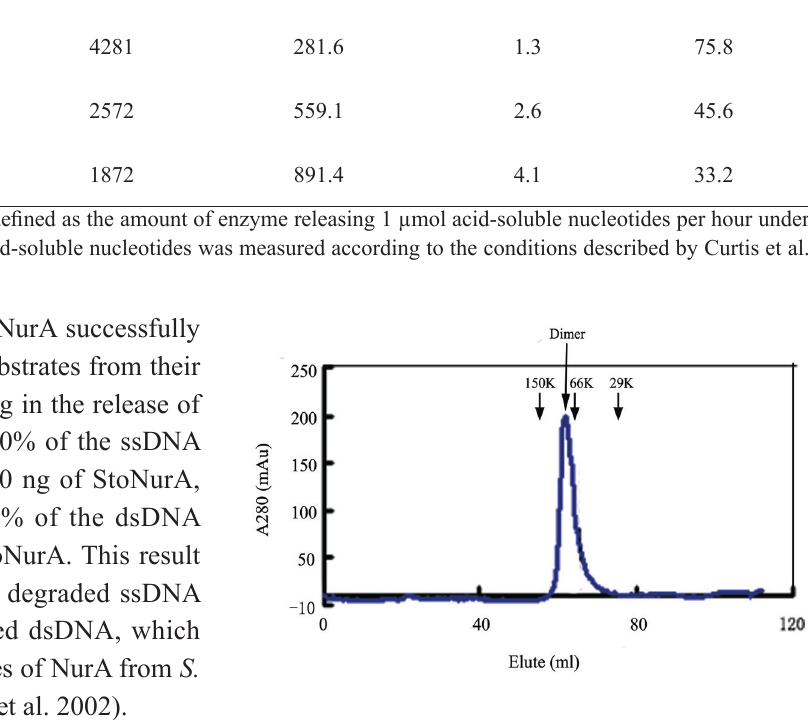
Figure 2 - Gel filtration analysis of StoNurA using Sephacryl S-200 column. The arrows indicated the eluted positions of StoNurA and protein markers (from left to the right): alcohol dehydrogenase (150 kDa, 54.12 ml), StoNurA (60.85